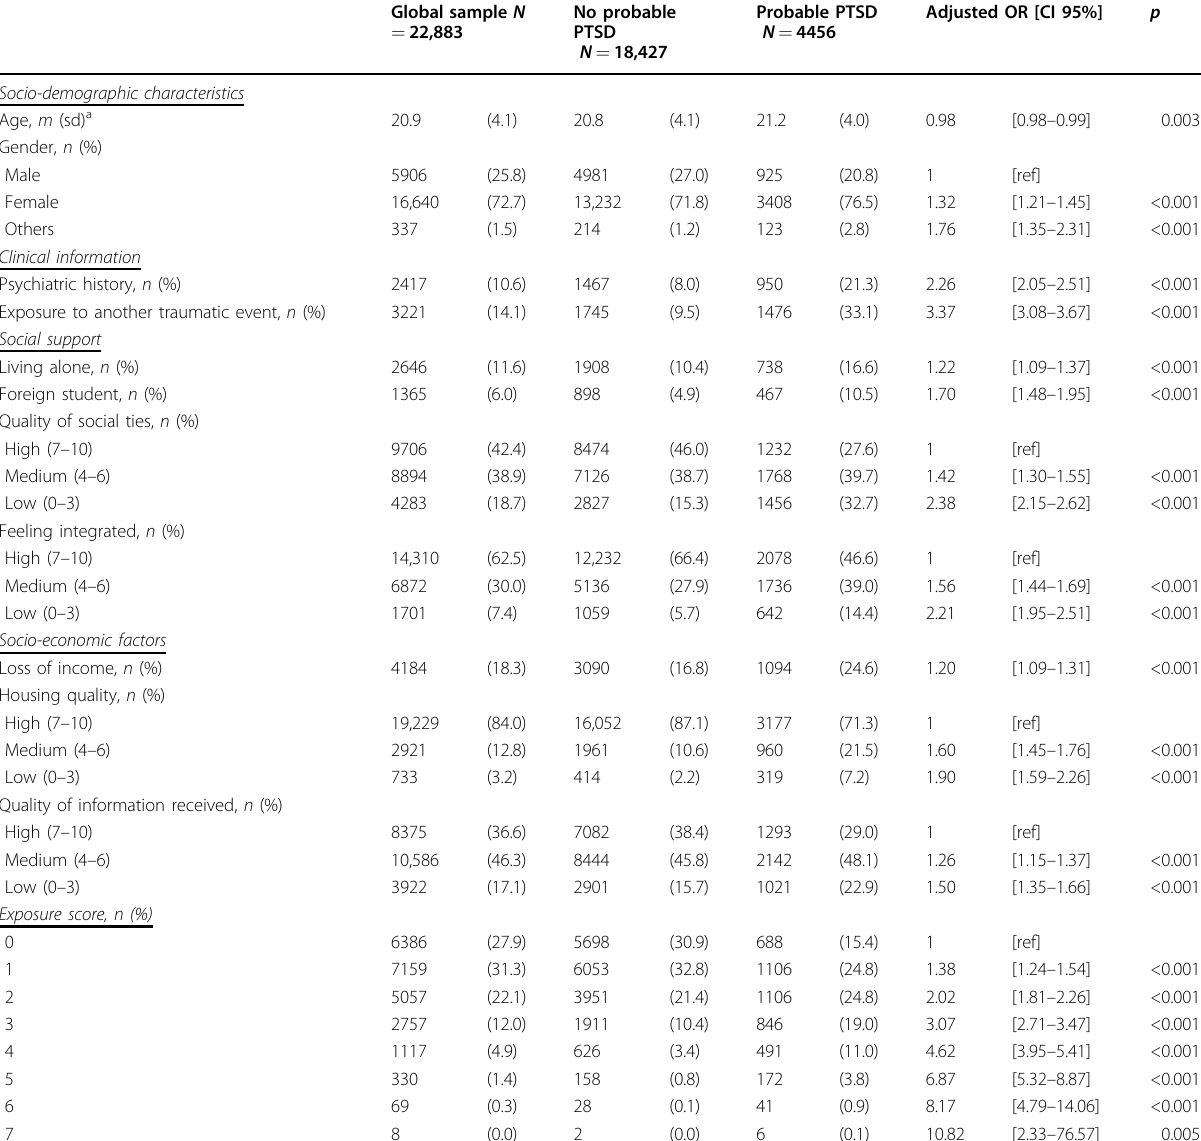
Table 1 Characteristics of the sample and factors associated with probable PTSD in the global sample according to multivariate logistic regression